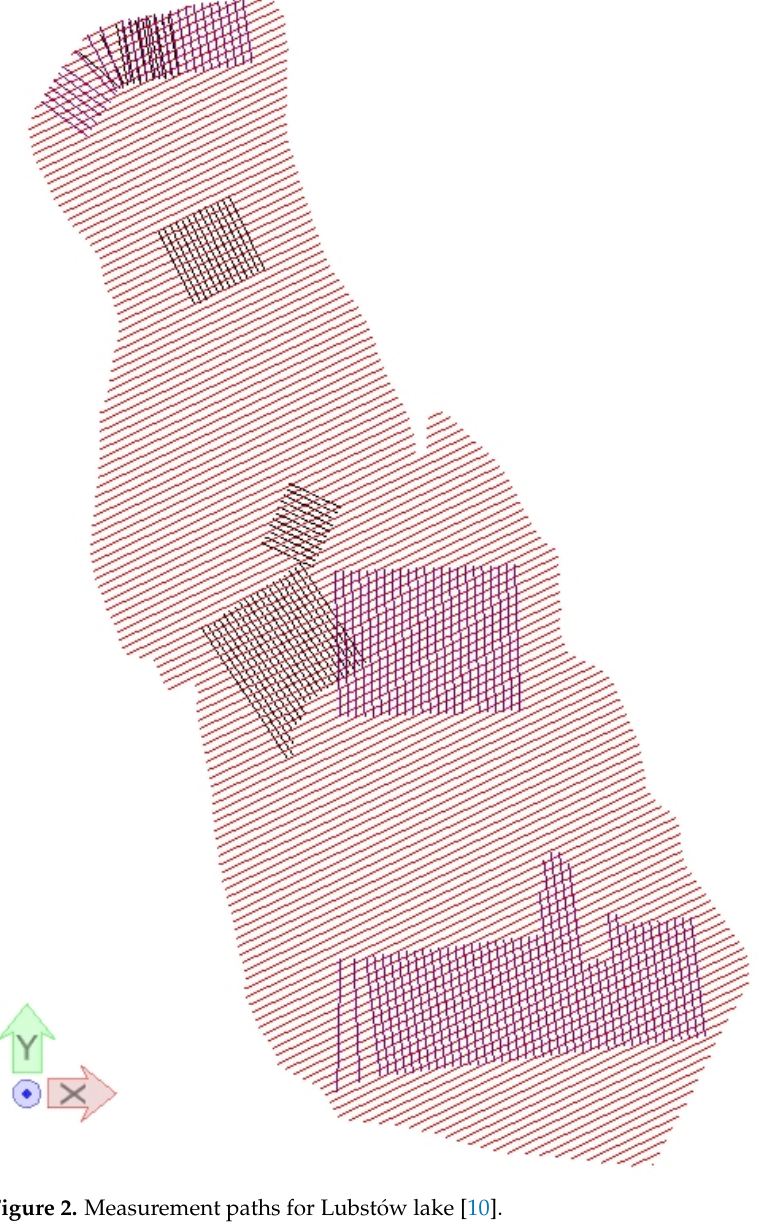
Figure 2. Measurement paths for Lubstów lake [10].